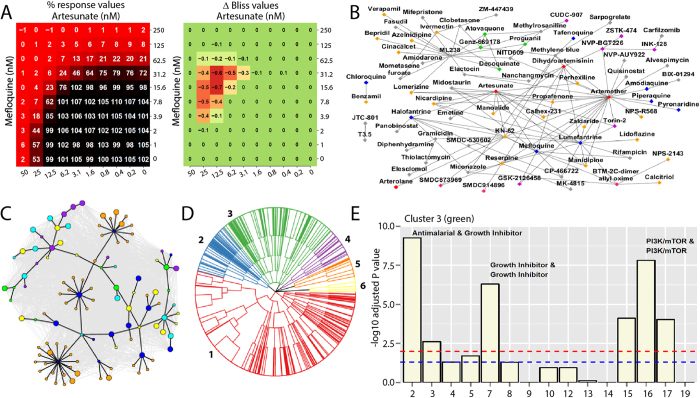
Single agent and combination analysis of a large collection of approved and investigational drugs for antimalarial activity.(A) Examples of response profiles (10 × 10 plots) for Artesunate (AS) + Mefloquine (MFQ). Percent response values represent normalized growth, relative to controls based on SybrGreen fluorescence intensities. (B) Interaction plot of combinations passing a defined threshold (DBSumNeg <−3; reflecting synergy) against the Plasmodium falciparum 3D7 strain ( = Endoperoxides;  = HLF, LUM, MFQ, CQ, TFQ;  = hPI3K/mTOR;  = mitochondrial/DHODH;  = ion channel modulator;  = hybrid mechanism;  = other). Vector lengths do not reflect the strength or weakness of the interaction. Additional network plots reflecting antagonistic outcomes are found in the SI. Enlarged versions of this figure can be found online at http://tripod.nih.gov/pub/malaria-matrix/. (C) The interaction network formed from 2134 combinations of 111 single agents is colored grey. Overlaid on top (black edges) is the sub-network of 110 combinations involving all the single agents representing the most synergistic combinations (as measured by the sum of the DBSumNeg metric). ( = antimalarial drugs;  = growth inhibitor;  = hPI3K/mTOR;  = mitochondrial/DHODH;  = ion channel modulator;  = signaling/transporter inhibitor. Large symbols correspond to the high potency class and small symbols correspond to medium potency class). (D) Hierarchical clustering of combination profiles based upon 1) synergy assessment; 2) potency class; 3) mechanism of action (MOA) relationship. The number of clusters (six) was selected based on the largest number of clusters that led to zero or one cluster that was not enriched in any MOA combination (at the 0.01 level). (E) A summary of MOA combinations enriched in cluster 3 (green), relative to the entire dataset (see SI for full list of code definitions). Enrichment was tested using Fisher’s exact test with p-values adjusted using the Benjamini-Hochberg method, and plotted as –log10 p-value. The blue and red dashed lines correspond to p = 0.05 and p = 0.01 respectively. While six MOA combinations were significant at the 0.01 level, we annotated the top three. See SI for full figure.